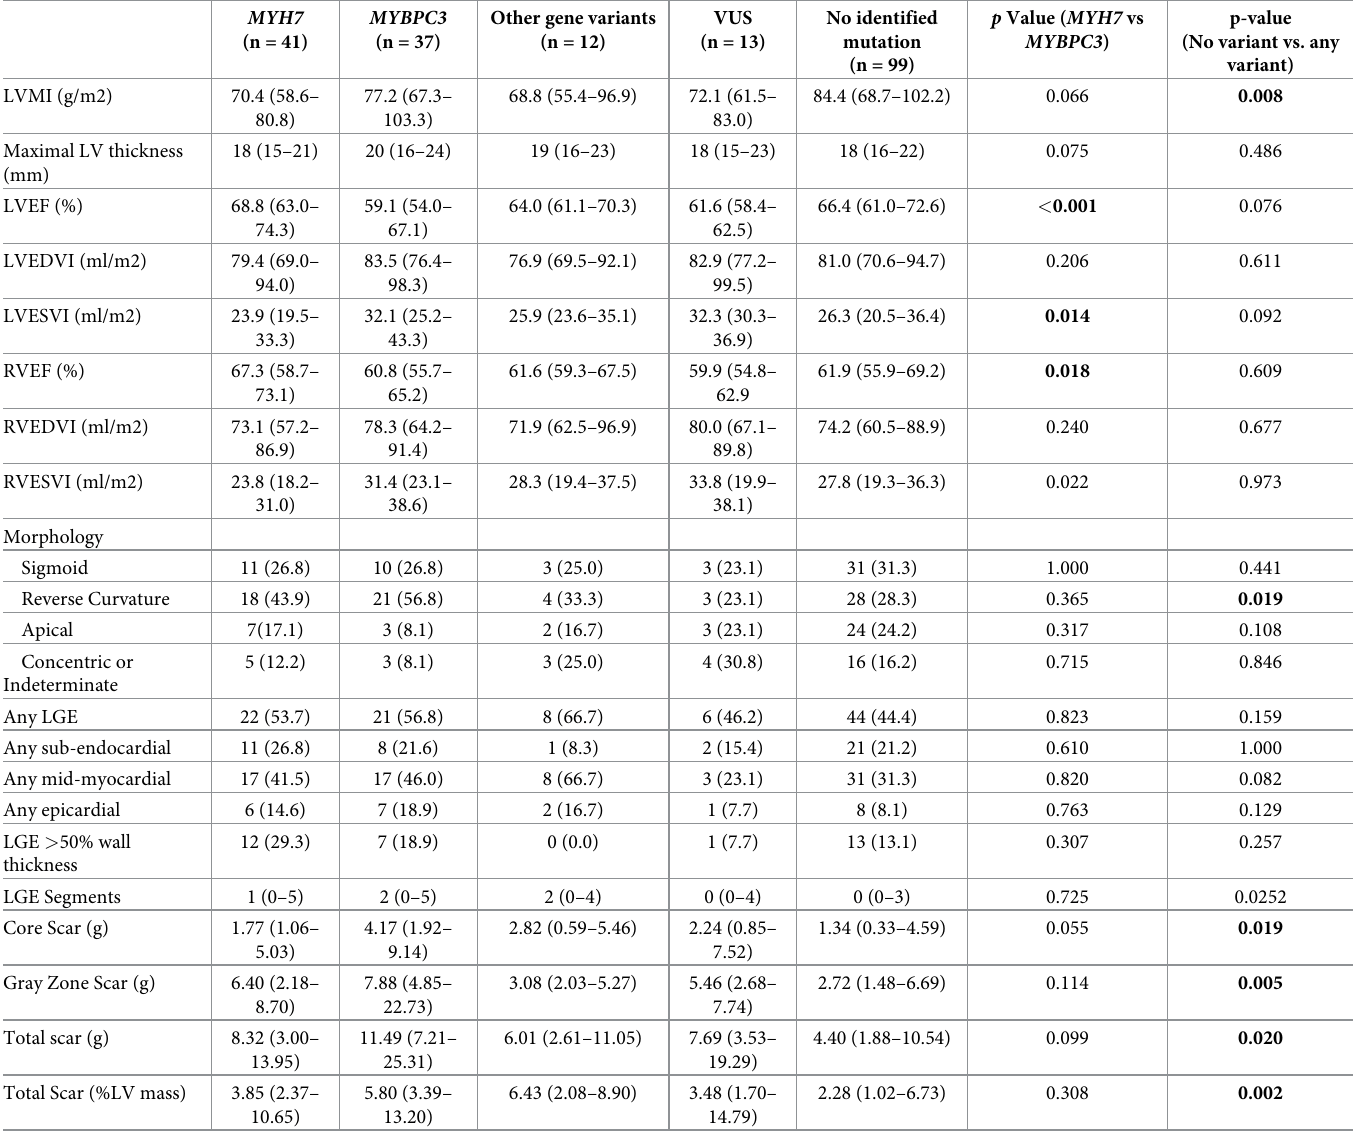
Table 3. CMR characteristics stratified by